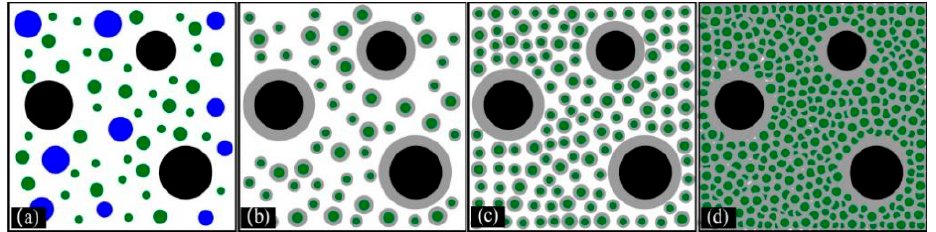
Figure 16. Microstructure of CaCO 3 crystal nucleus before formation of CO 2 ‐ absorbing slurry. ( a ) No reaction occurred when the slurry absorbed CO 2 ; ( b ) Slurry absorbs 0.44% CO 2 at late hydration stage; ( c ) Slurry absorbs 1.32% CO 2 at late hydration stage; ( d ) Slurry absorbs 2.20% CO 2 at late hydration stage.